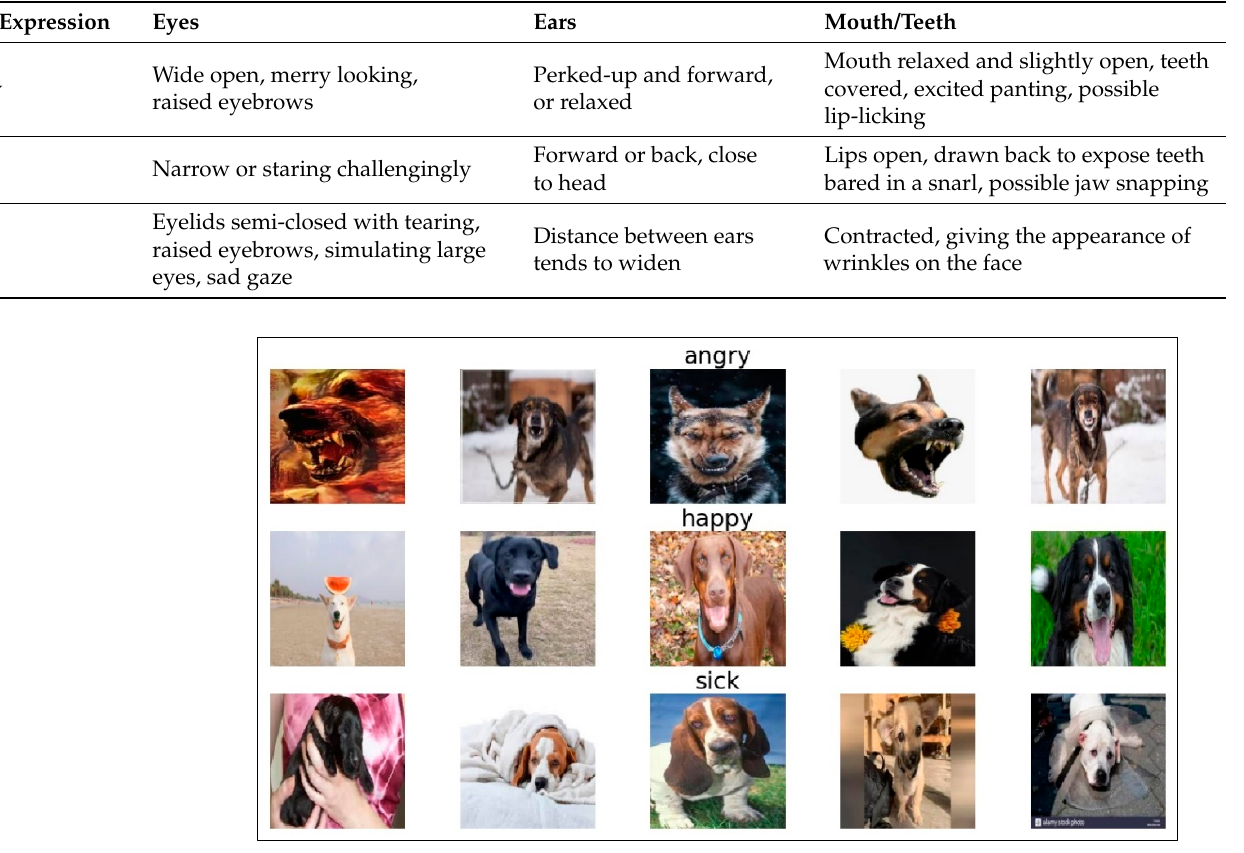
Figure 3. Sample images of dogs with various expressions.